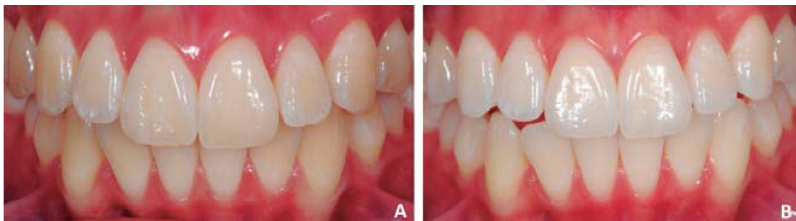
Figure 7- A: Teenage girl, presented with white enamel stain on the maxillary and mandibular teeth; B: After tooth bleaching with 15% carbamide peroxide Opalescence. In some cases, when white stains are small and not prominent, dental bleaching alone using carbamide peroxide or hydrogen peroxide in custom trays may lighten the underlying dentin and (cid:18)(cid:19)(cid:8)(cid:16)(cid:18)(cid:7)(cid:12)(cid:11)(cid:15)(cid:27)(cid:22)(cid:17)(cid:10)(cid:18)(cid:19)(cid:14)(cid:7)(cid:6)(cid:12)(cid:14)(cid:4)(cid:12)(cid:17)(cid:8)(cid:16)(cid:4)(cid:15)!(cid:8)(cid:25)(cid:18)(cid:12)(cid:14)(cid:5)(cid:18)(cid:12)(cid:11)(cid:14)(cid:8)(cid:10)(cid:19)(cid:21)(cid:12)(cid:13)(cid:10)(cid:14)(cid:5)(cid:12)(cid:19)(cid:4)(cid:12)(cid:19)(cid:18)(cid:18)(cid:20)(cid:12)(cid:27)(cid:4)(cid:3)(cid:12)(cid:16)(cid:10)(cid:17)(cid:3)(cid:4)(cid:8)(cid:24)(cid:3)(cid:8)(cid:11)(cid:10)(cid:4)(cid:19)